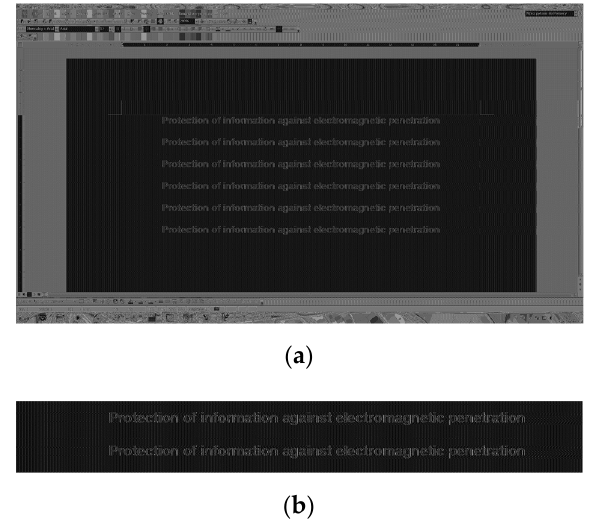
Figure 7. Image ( a ) obtained by using a TMDS signal differentiation operation (Figure 6b) and its enlarged fragment ( b ).